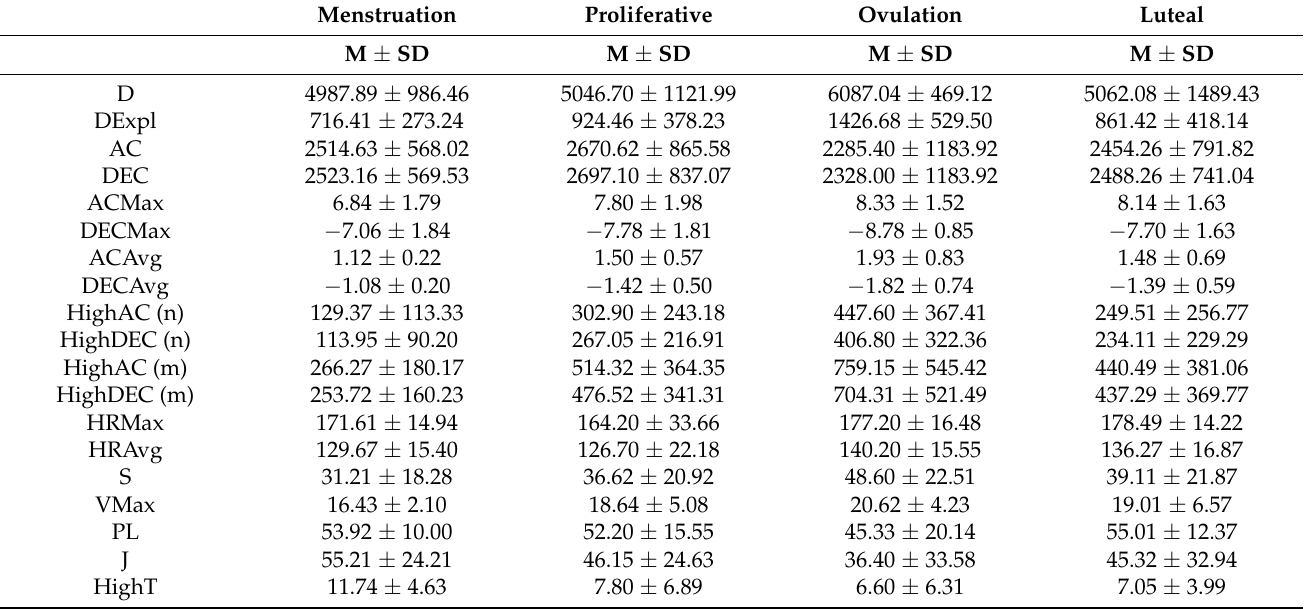
Table 3. Results of the descriptive analysis according to the phases of the MC.